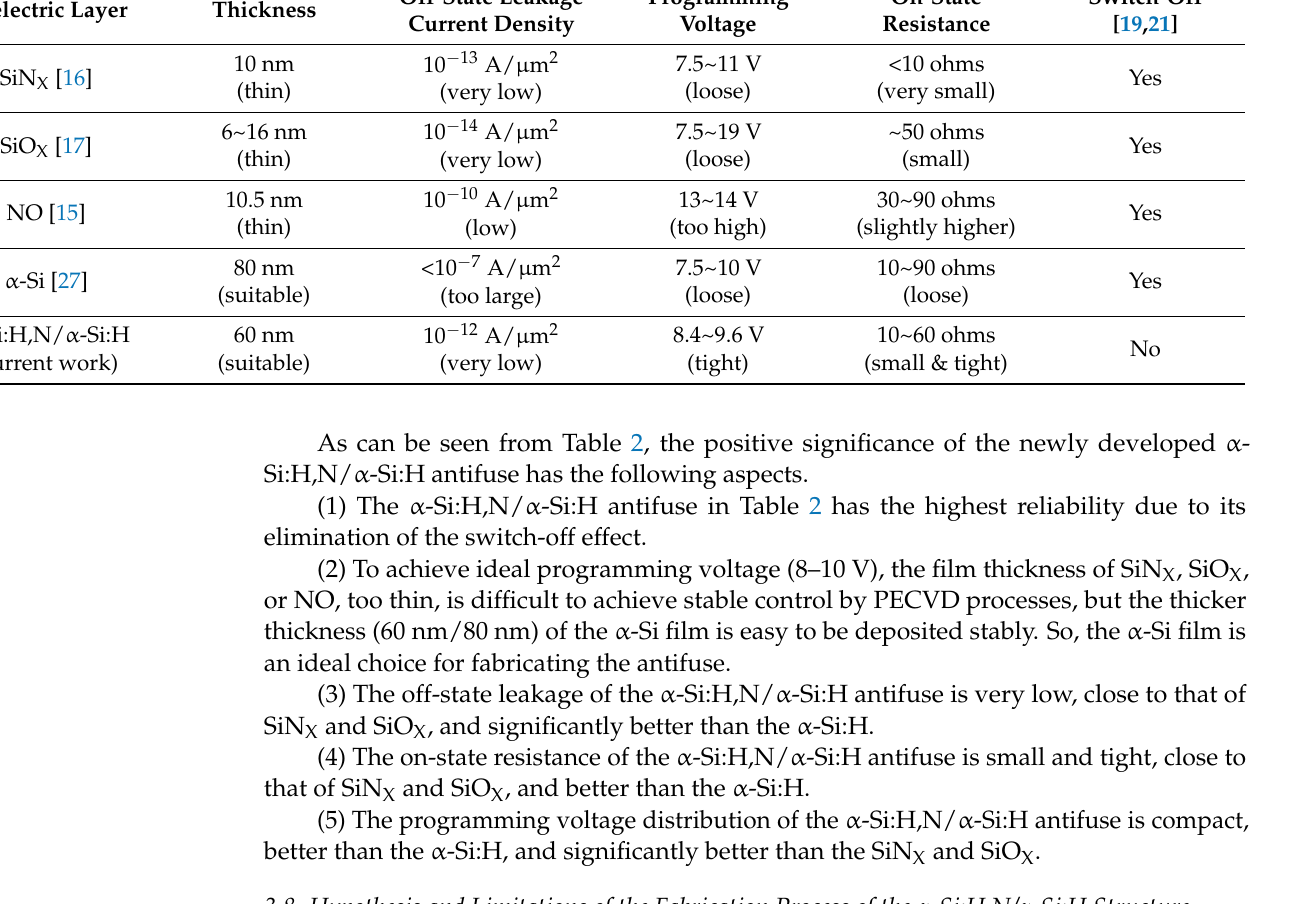
Table 2. The comparison between the previous works and the current work. Dielectric